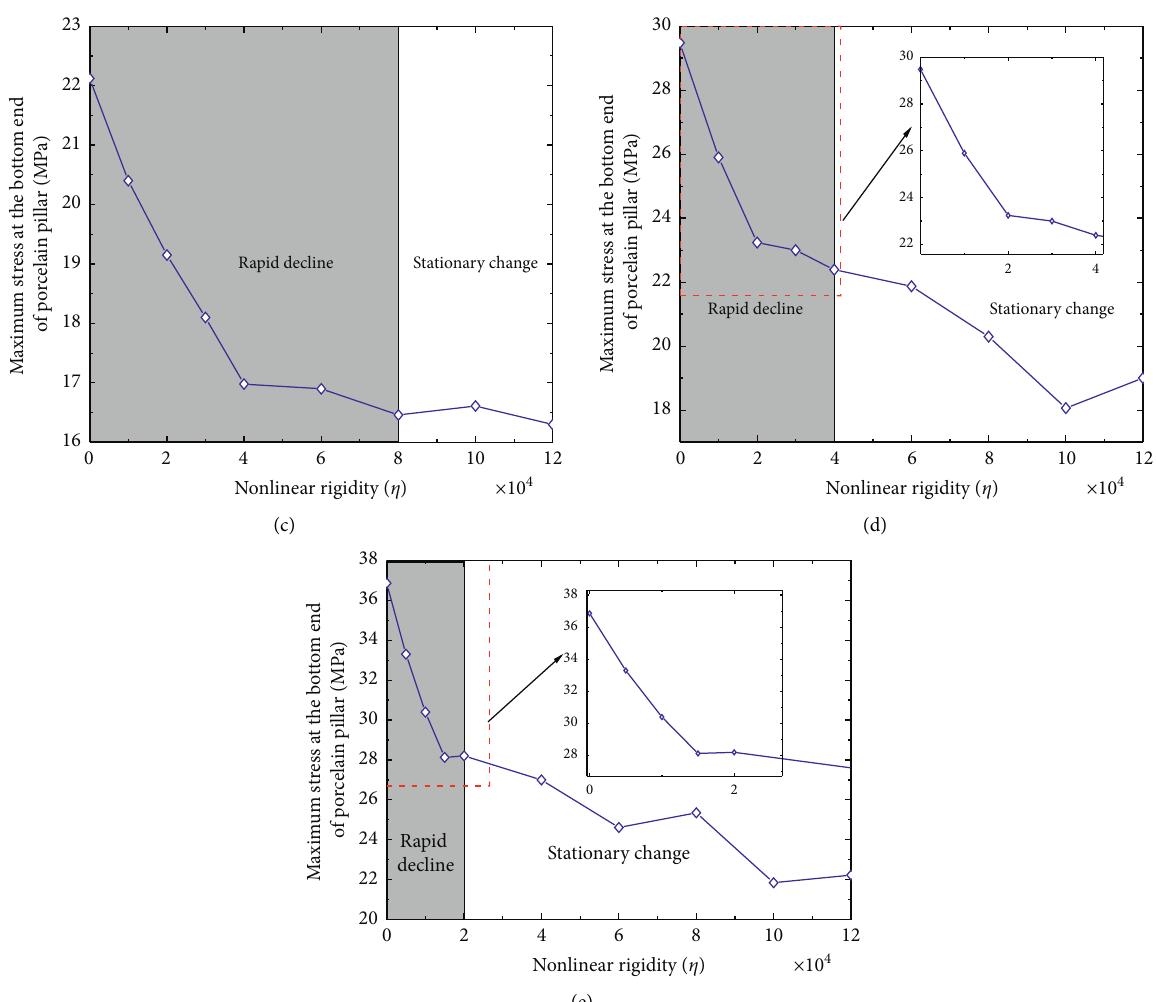
Figure 27: Curves of the relation between nonlinear rigidity parameter and maximum stress of equipment under different seismic ex- citations. (a) 0.1g. (b) 0.2 g. (c) 0.3 g. (d) 0.4g. (e) 0.5